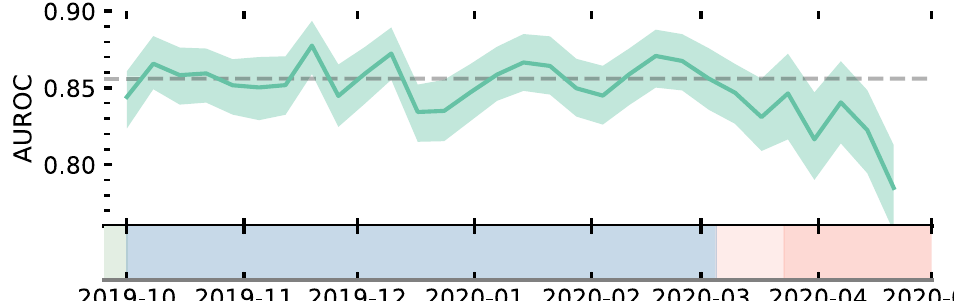
Figure 3. Time evolution of model performance evaluated by the area under the receiver operating characteristic curve (AUROC). AUROC values for the model are evaluated in weekly bins throughout the complete test period. Errorbars are 95% CI found from bootstrapping of each bin. The grey dotted line shows the average AUROC of the model evaluated on attendances occurring before the COVID-19 pandemic. Shading refers to the timeline defined in Fig.